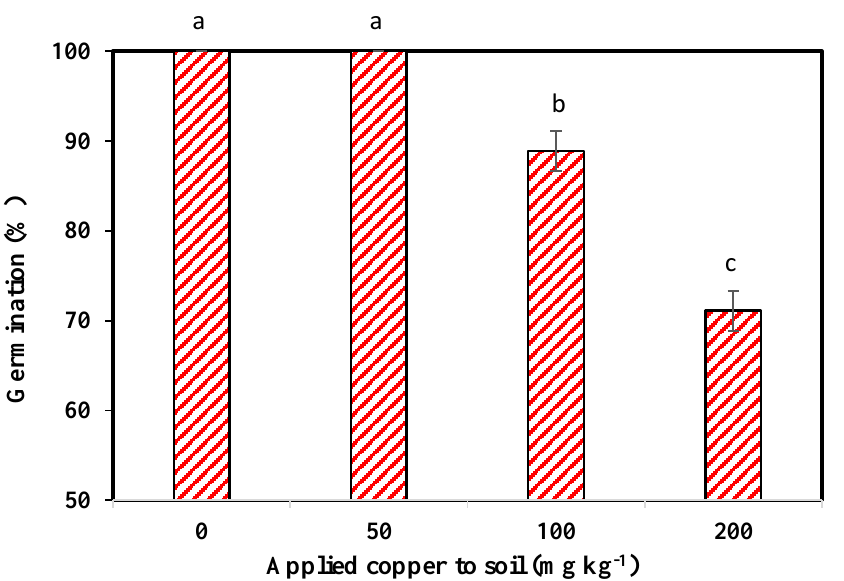
Figure 1. Ultimate germination of Zea mays in contaminated soil with 0, 50, 100 and 200 mg kg −1 copper. Mean values that do not share a letter are significantly different at p = 0.05 (mean ± S.E.; n = 3).